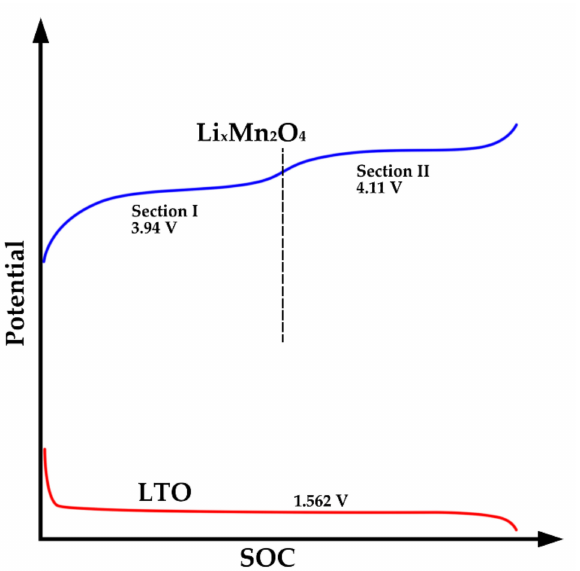
Figure 8. Schematics of potential of LTO and Li x Mn 2 O 4